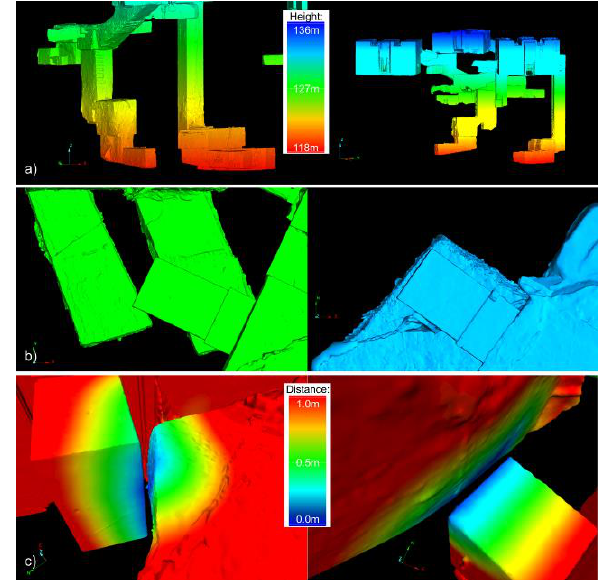
Figure 9. Views of the 3D models obtained: a) Similar height of the QH31 and the QH33 burial chambers; b) planimetric coincidence of the sanctuaries with the burial chambers (QH32 and QH33); c) examples of reduced distance between the QH32 and the QH33